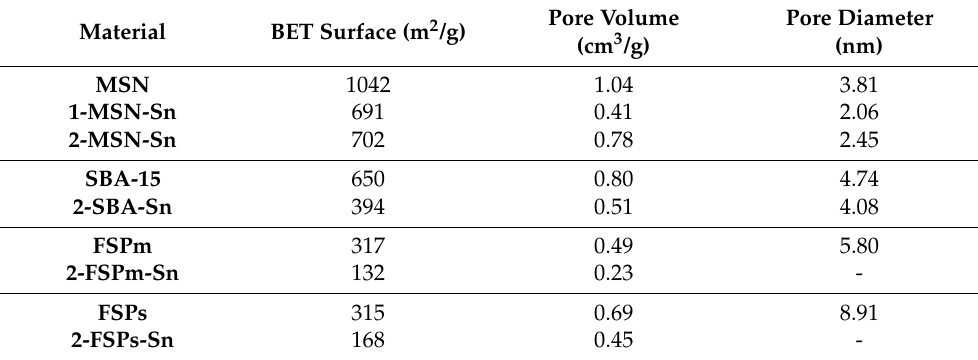
Table 1. Textural parameters obtained by nitrogen adsorption/desorption isotherms. Material BET Surface (m 2